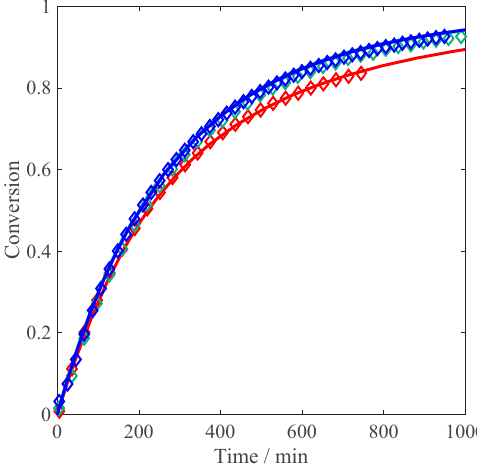
Figure 11. Monomer conversion versus time profiles of the radical batch polymerization of fully ionized MAA in aqueous solution at 50 °C, 0.1 wt % of V ‐ 50 initiator and constant ionic strength equivalent to 10 wt % MAA by addition of NaCl. Variation of monomer concentration 1 wt % (red), 5 wt % (green), and 10 wt % (blue, no NaCl addition): comparison between experimental data by in ‐ situ NMR (diamonds) and simulated curves (lines, using the parameter values of Table 6). Table 6. Estimated parameter values of the parameter optimization carried out by fitting the model equations to the experimental data of conversion versus time (cf. Figures 9–11) for the fully ionized MAA case. Parameter Value